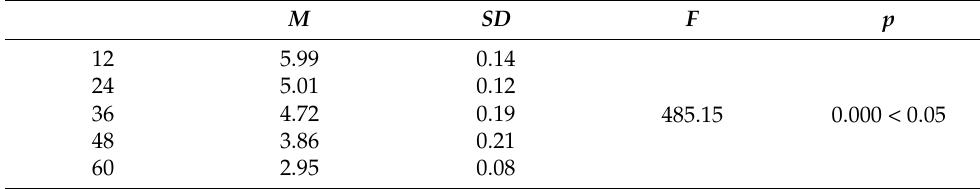
Figure 14. Response time of each speed target under intensity 252 stimulation. Table 8. Time statistic value under intensity 252.